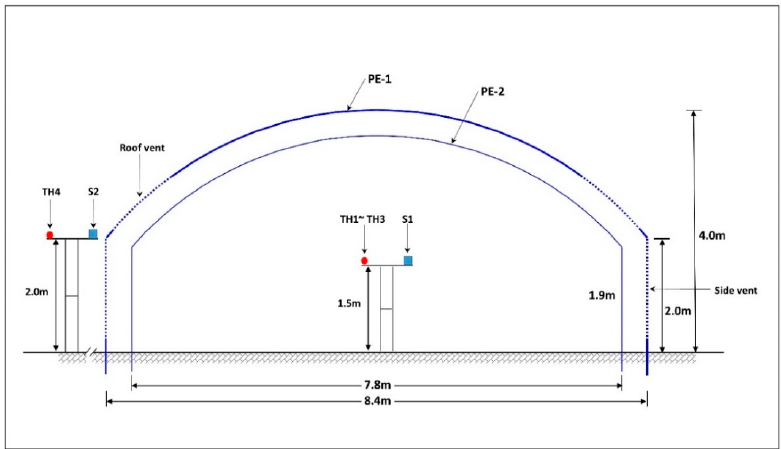
Figure 2. Dimensions and positions of sensors (S (solar radiation), TH (temperature & humidity)) in the experimental greenhouse. PE: Polyethylene.